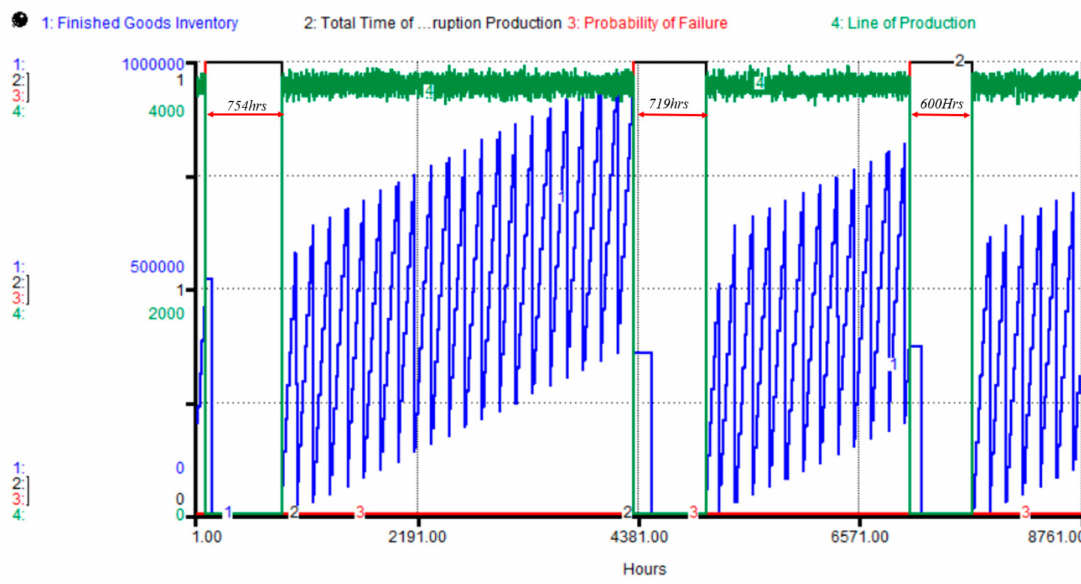
Figure 6. Disruption time in line of production with three failures.